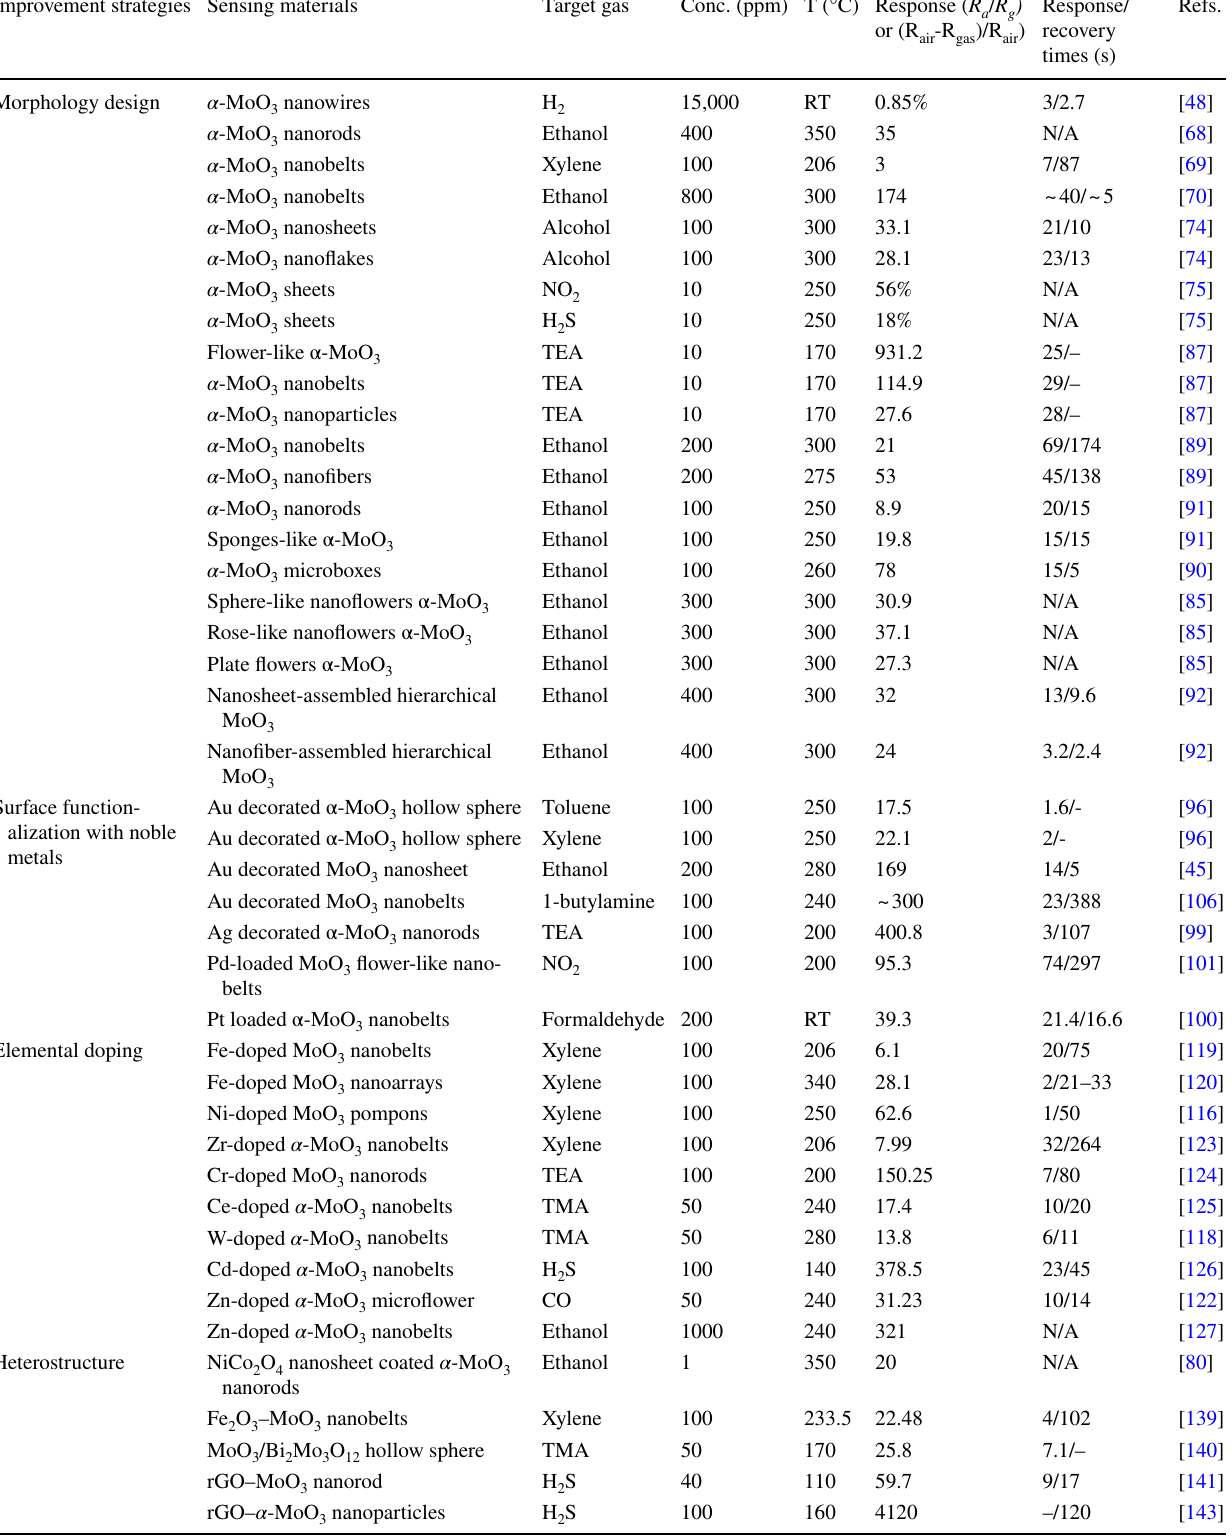
Table 1 Comparison of modification of MoO 3 technique in various gas detection Improvement strategies Sensing